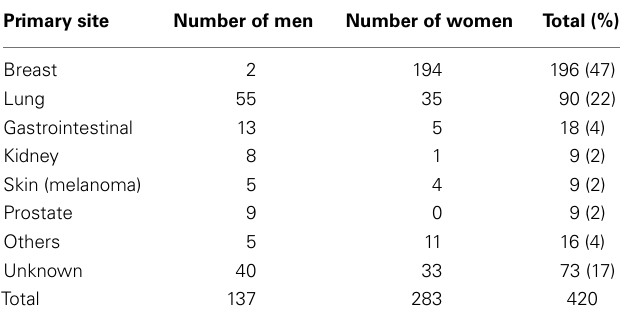
Table 1 |The most common sources of metastases to the choroid